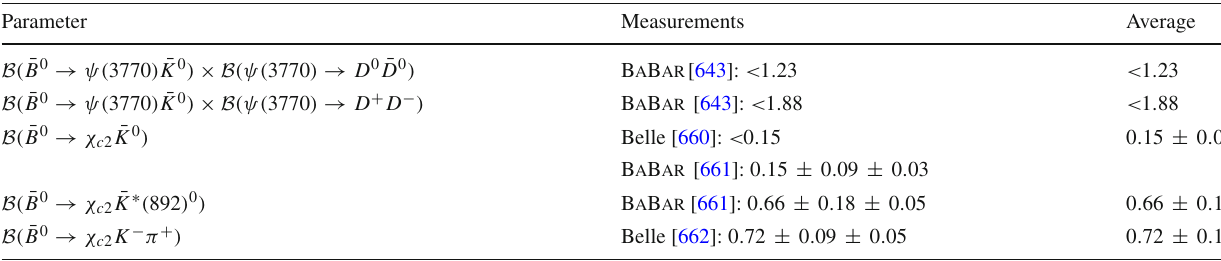
Table 118 Decays to charmonium other than J /ψ and one kaon II [ 10 − 4 ] Parameter